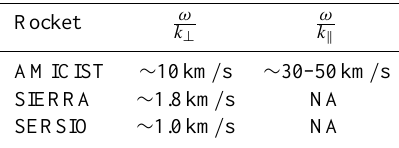
Table 3. Summary of the phase velocity measurements of